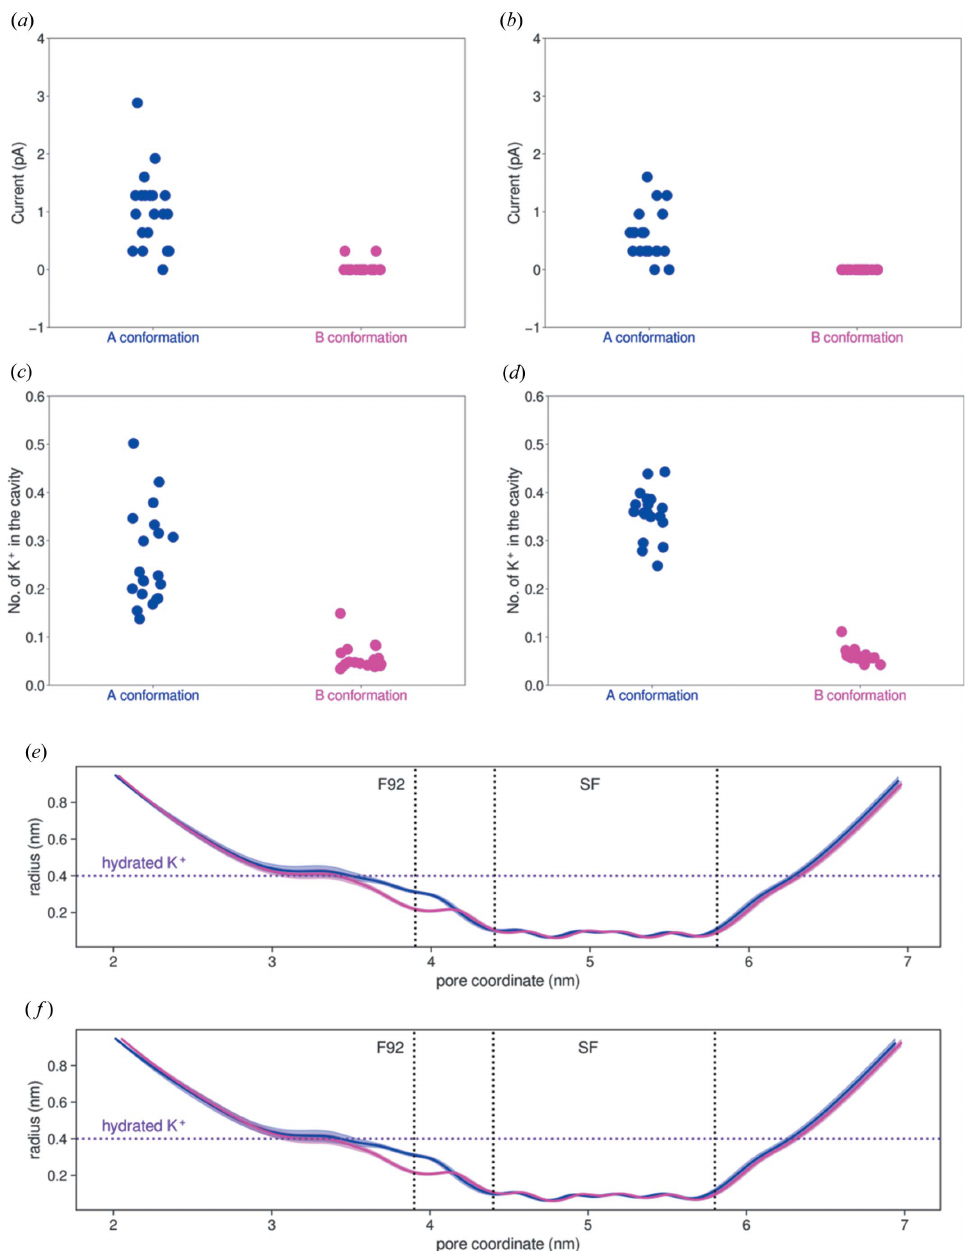
Figure 6 MD simulations of A (blue) and B (magenta) conformations of NaK2K. ( a ), ( b ) Ionic currents through NaK2K at the membrane voltages of 300 ( a ) and (cid:4) 300 mV ( b ). Each dot represents an independent 500 ns long MD simulation. ( c ), ( d ) An average number of potassium ions found in the cavity (ions within 0.6 nm of the center of mass of Phe92 were considered), at 300 and (cid:4) 300 mV, respectively. ( e ), ( f ) Pore radius profiles for simulations at 300 and (cid:4) 300 mV, respectively. The horizontal purple line marks the typical radius of a fully hydrated potassium ion. The average position of the Phe92 aromatic ring is also indicated, as well as the selectivity filter. The error bars indicate 95% confidence